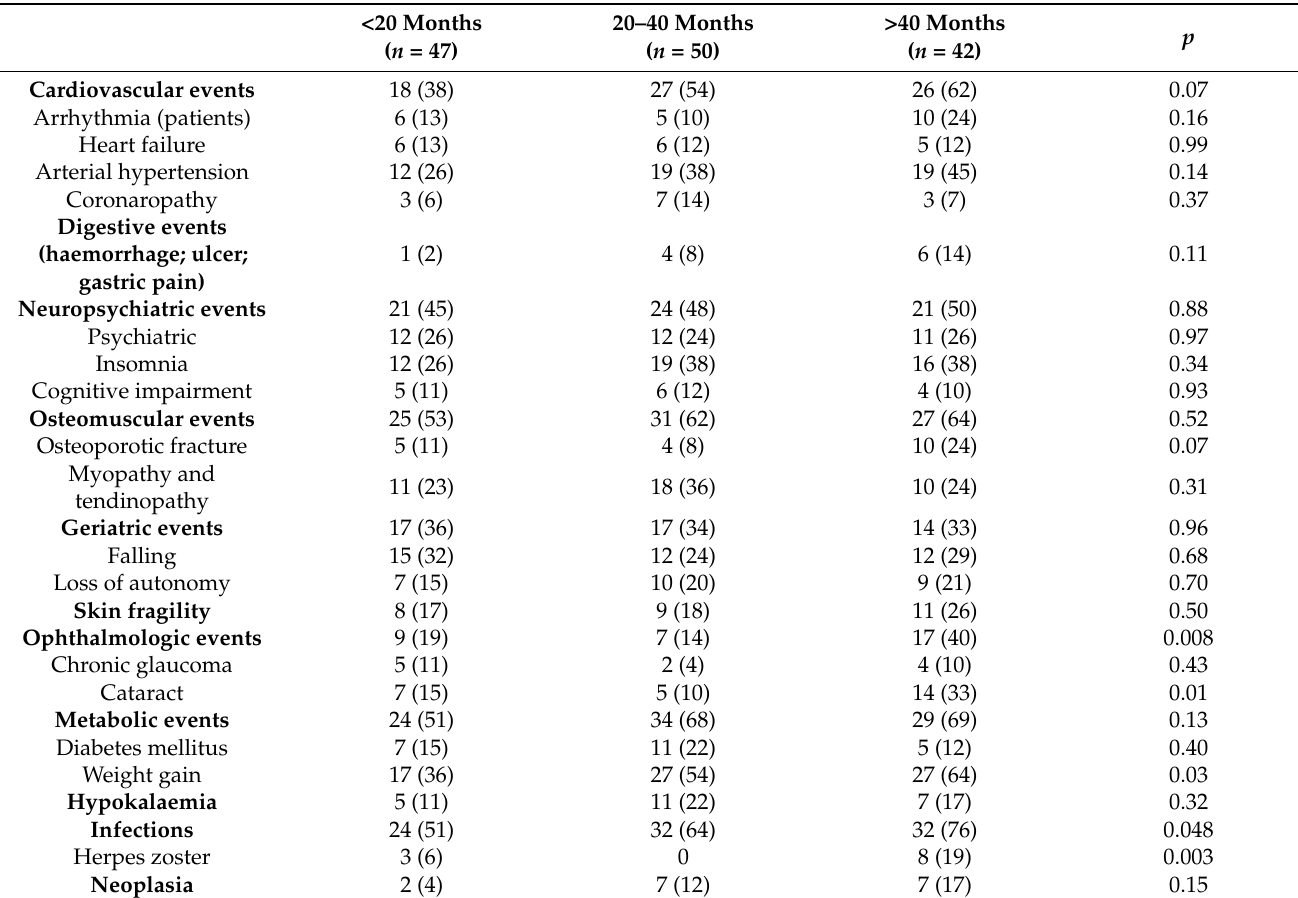
Table 4. Glucocorticoid-related AEs in GCA patients according to three groups of GC